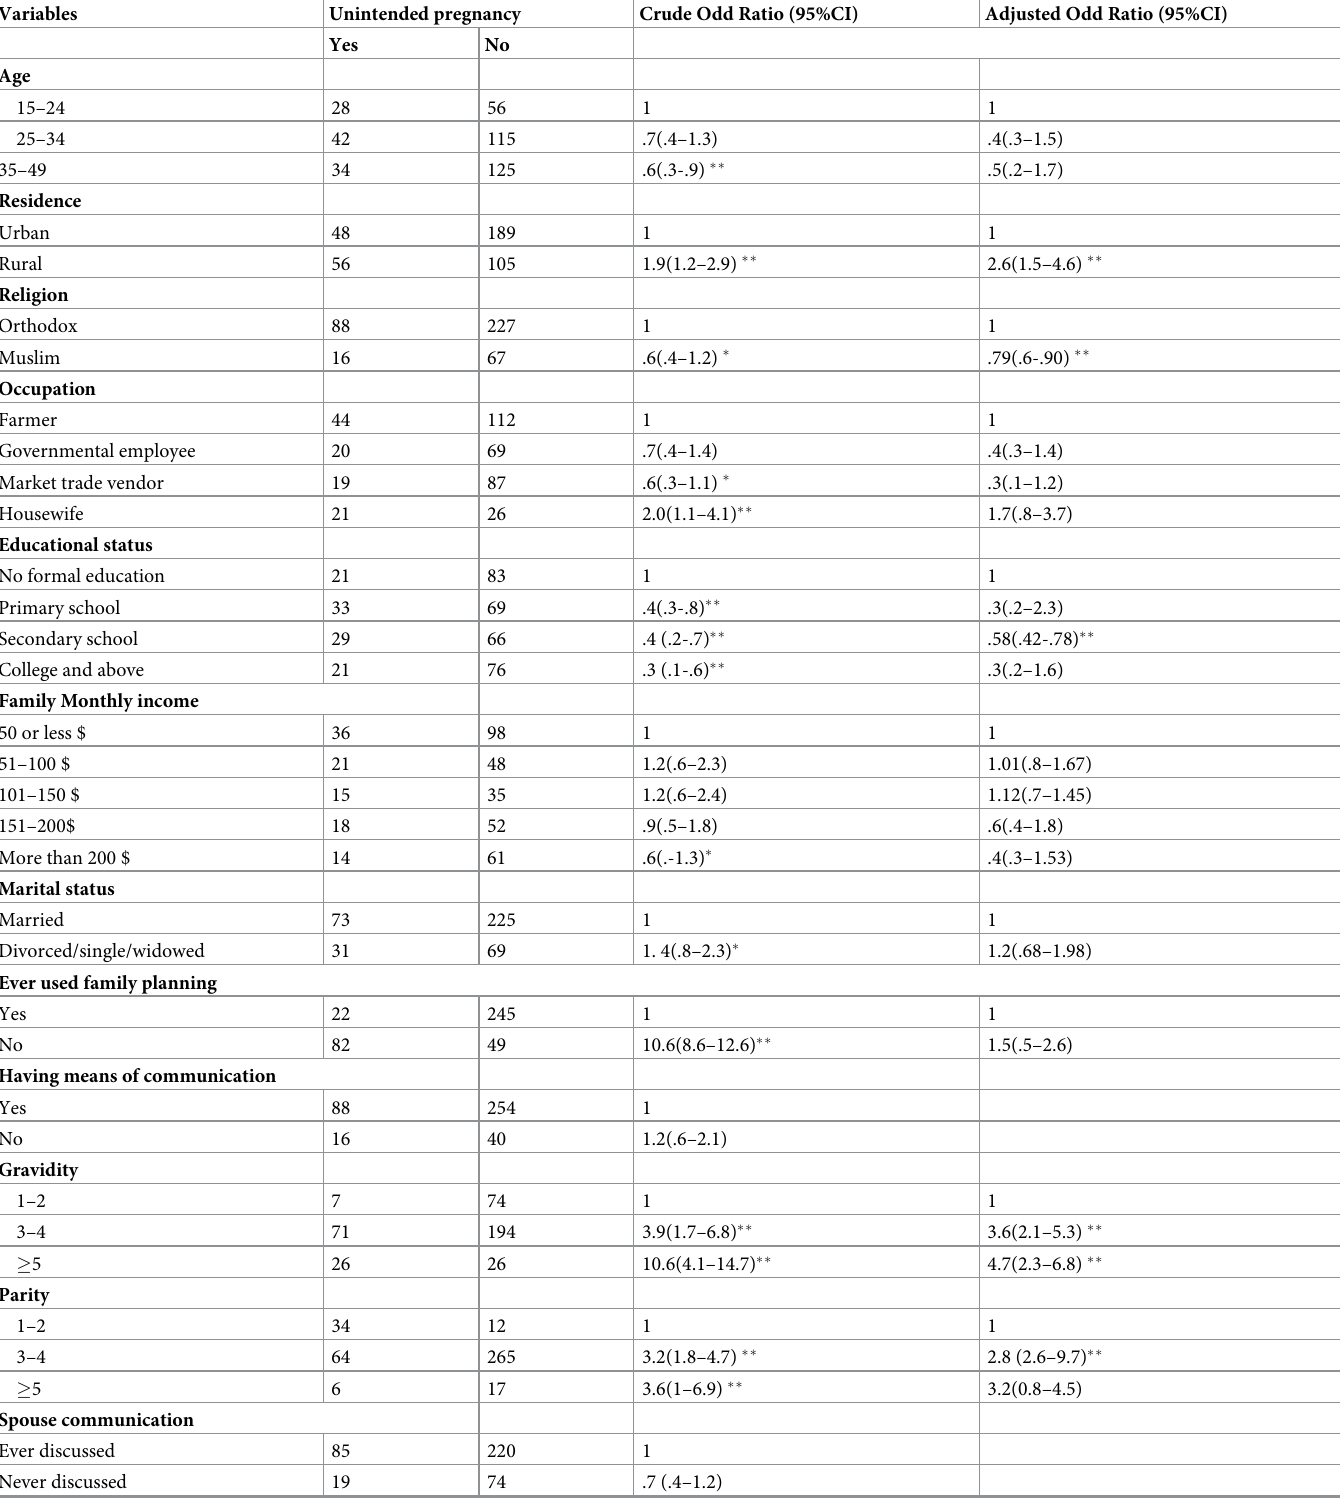
Table 3. Determinant factors of unintended pregnancy in Addis Zemen primary hospital, Northwestern Ethiopia, 2018(n =